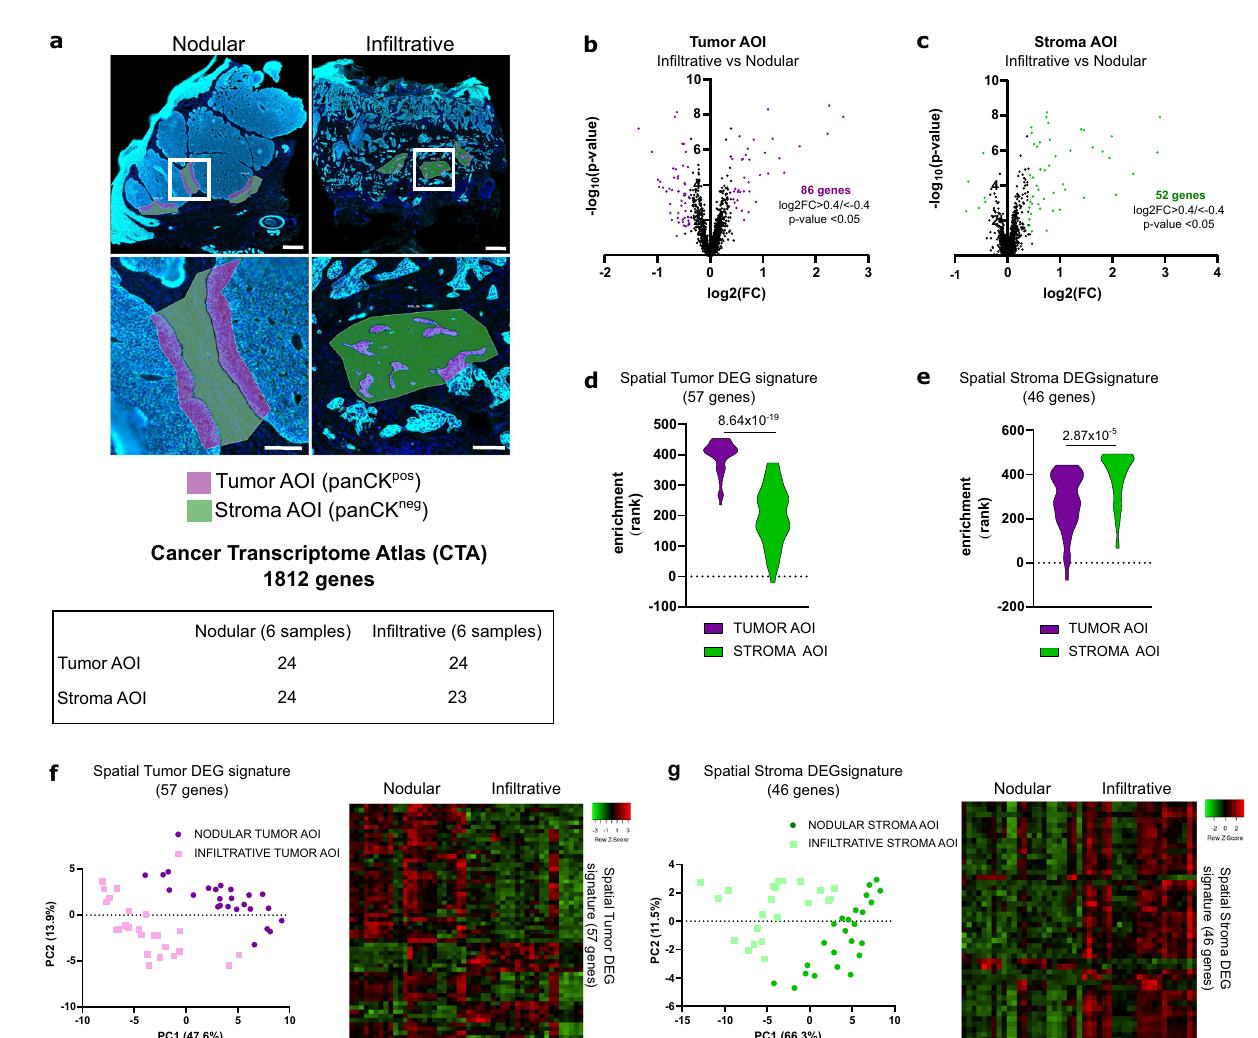
Fig. 2 | Spatial transcriptomics de fi nes compartment-speci fi c signatures for nodularandin fi ltrativetumor – stromainterfaces.a Immuno fl uorescenceimages of nodular and in fi ltrative BCC samples stained with DAPI and a panCK antibody showing the ROIs selection process and AOIs subdivision based on panCK staining. The table indicates the number of AOI for each tumor subtype (6 nodular and 6 in fi ltrative samples) and compartment (Tumor or Stroma). Scale bars indicate 300 µ m (upper panels) and 100 µ m (lower panels). b Volcano plot of the DEGs comparingthein fi ltrativetothenodulartumorAOIs.Eighty-sixgenes(highlightedin purple) show a log 2 fold change (log2FC) >0.4 or < − 0.4 with a p value <0.05. c Volcano plot of the DEGs comparing the in fi ltrative to the nodular stroma AOIs.